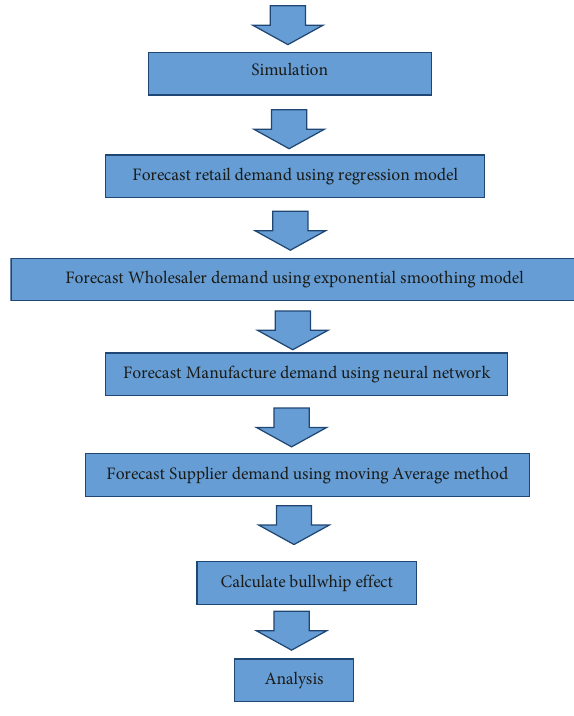
Figure 1: Research framework.